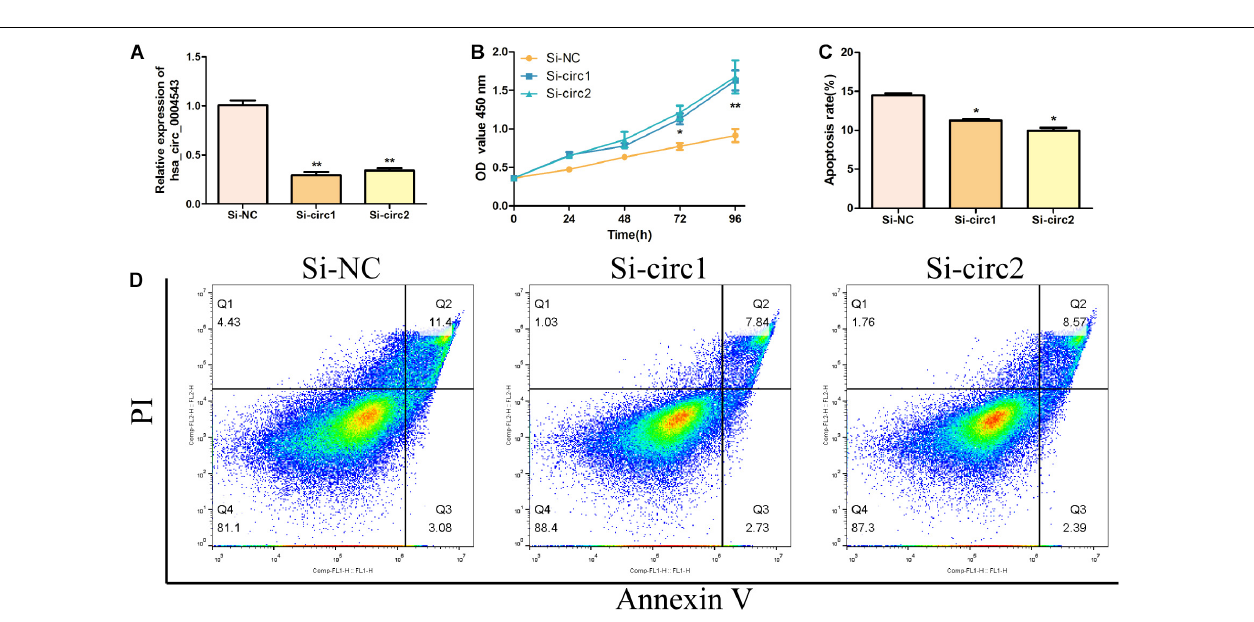
FIGURE 2 | Silencing of hsa_circ_0004543 increases the proliferation of HUVECs induced by oxLDL. (A) The expression of hsa_circ_0004543 was suppressed by siRNAs. (B) The CCK-8 assay was used to measure the cell viability of oxLDL-induced HUVECs. (C,D) The apoptotic rate differences in HUVECs were assessed between si-NC and si-circ1&2. * p < 0.05, ** p < 0.01.